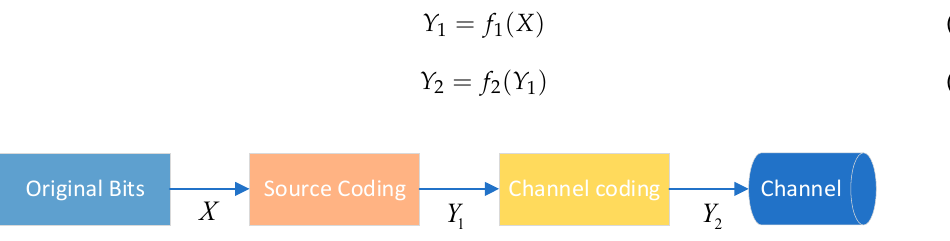
Figure 6. Basic framework of transmitter of traditional communication system.